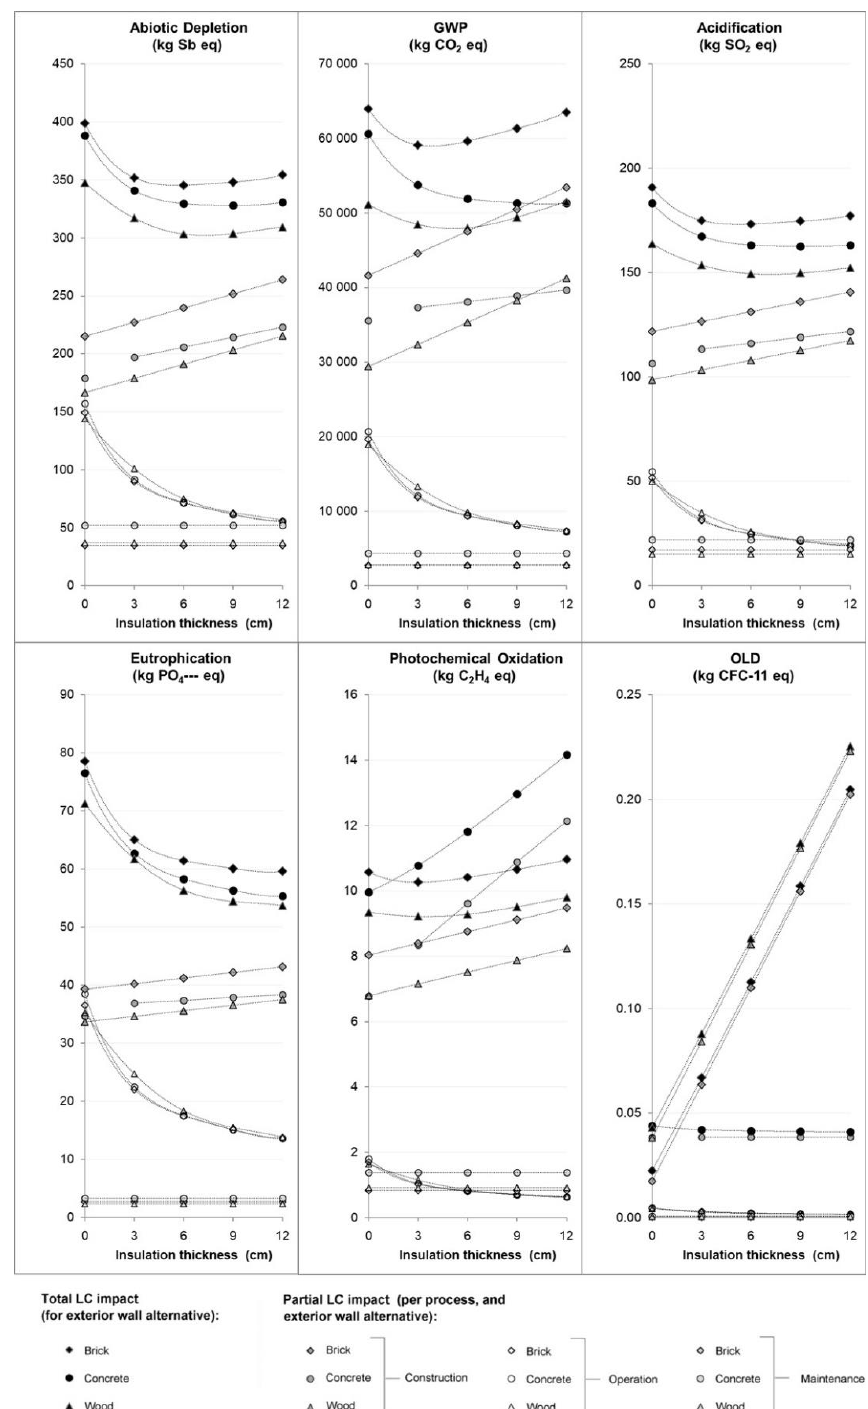
Figure 5. LCIA house results for OP25: exterior wall construction alternatives vs. insulation level.